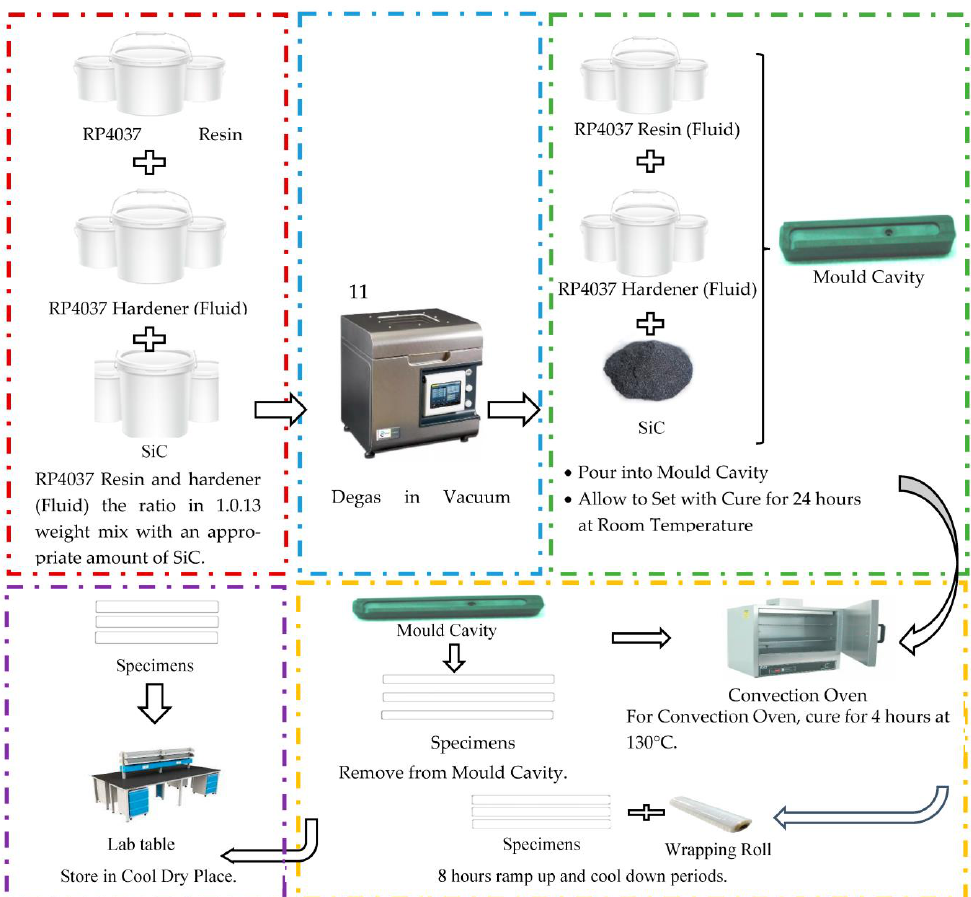
Figure 5. Method for setting up a tooling board.